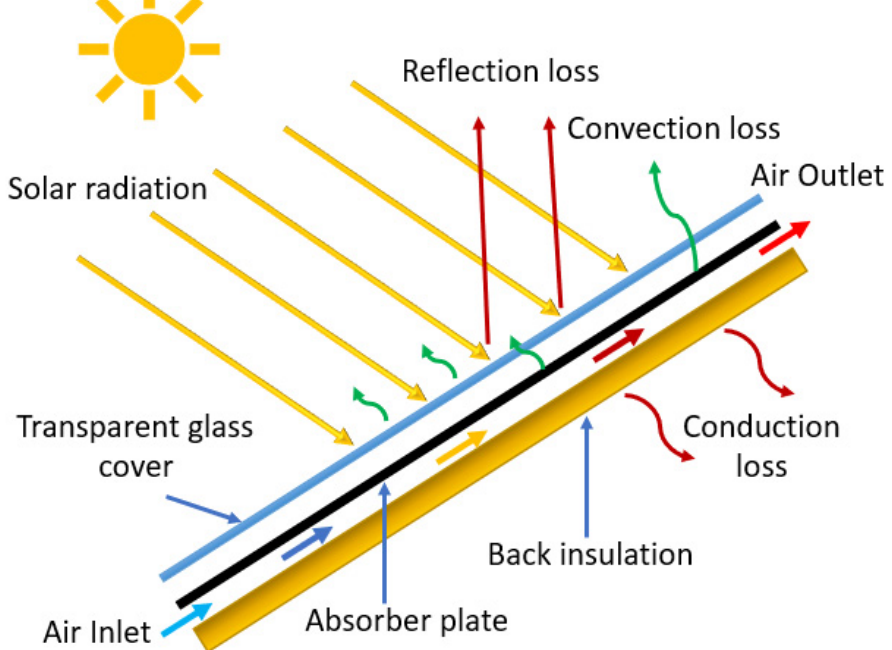
Figure 1. Basic illustration of a solar air heater (SAH).